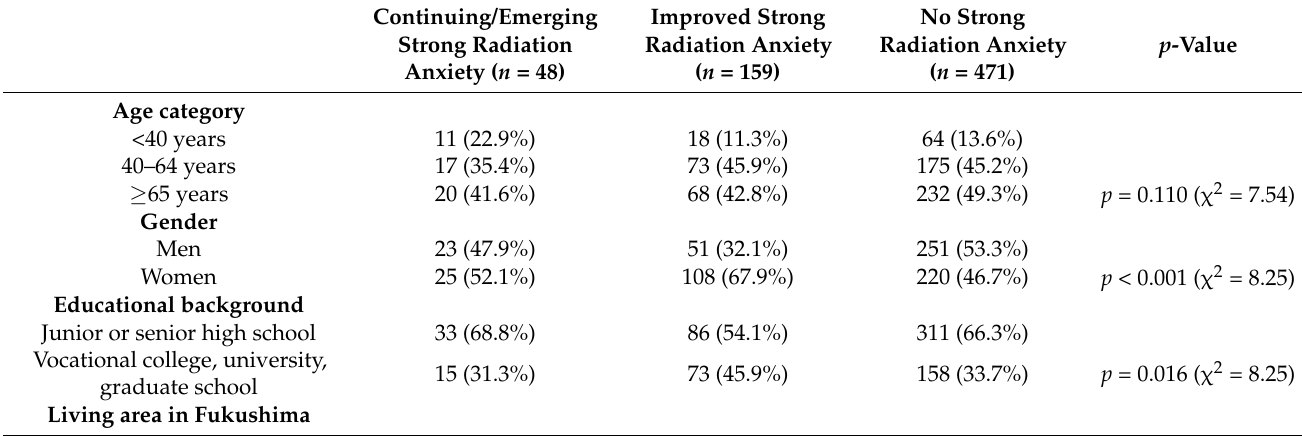
those living in the evacuation area and Naka-Dori had higher proportions (Table 4). Table 4. Basic characteristics of continuing, emerging, improved, and no strong radiation anxiety for